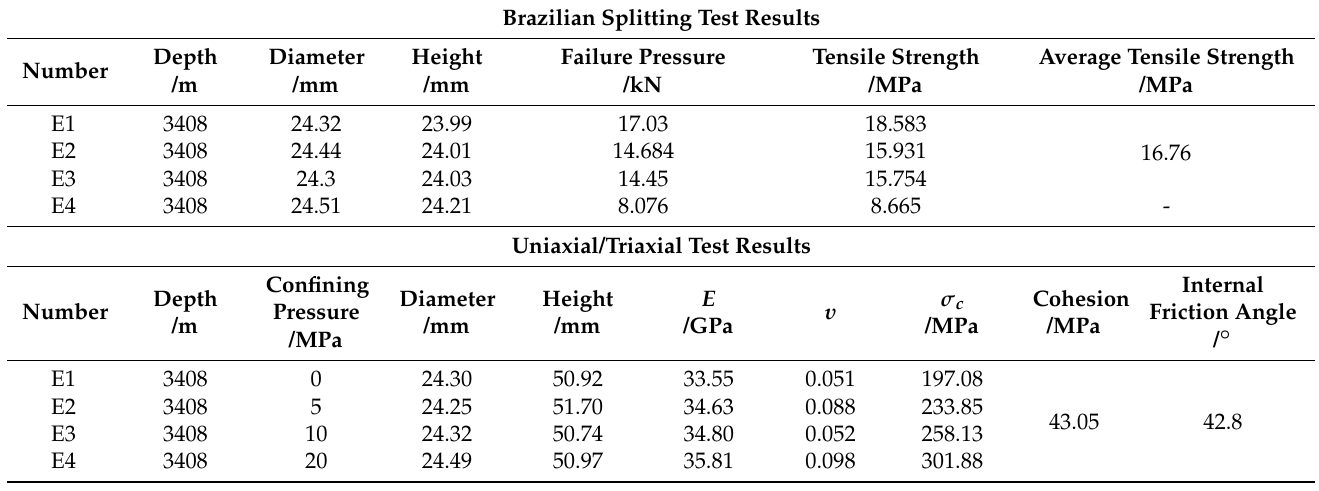
Table 1. Test results of rock mechanical